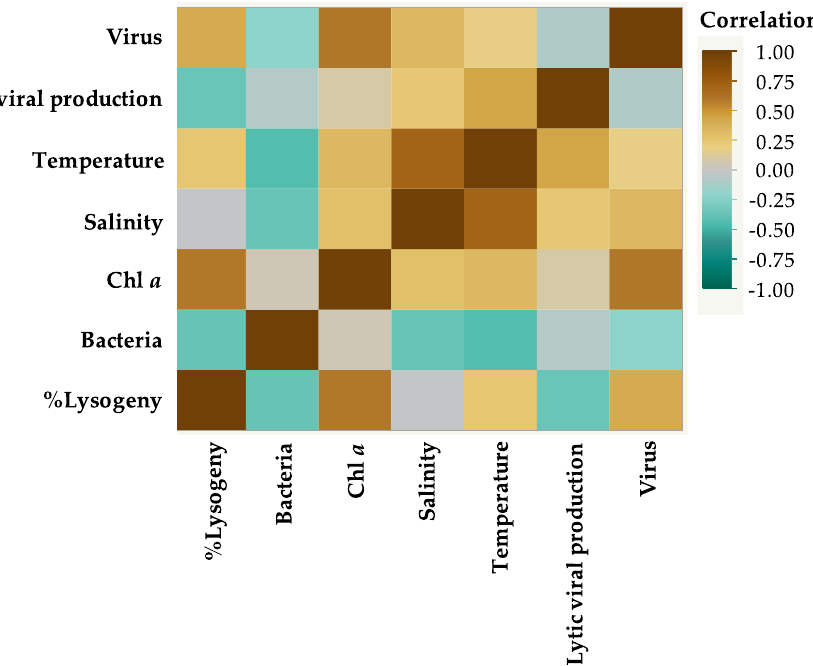
Figure 3. Correlation matrix between all the environmental parameters, viral and bacterial abundances, the percentage of lysogenic bacteria (%), and lytic viral production (LVP) rates (mL − 1 h − 1 ) observed during the study.